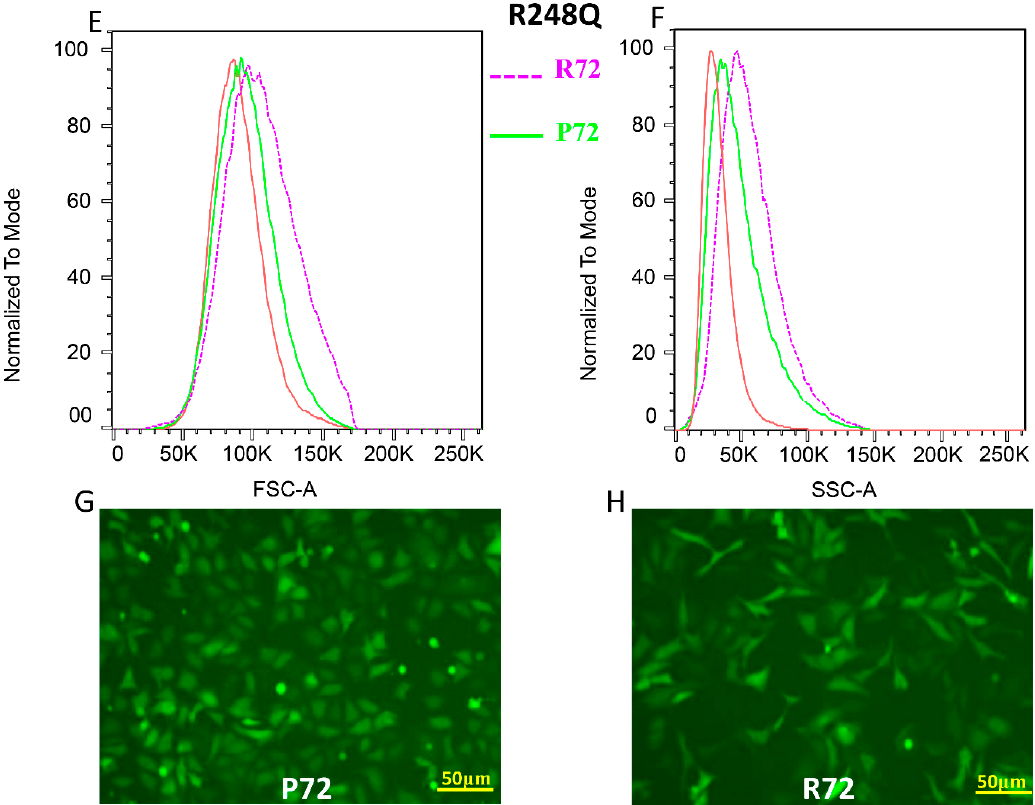
Figure 1. The P72R SNP alters the morphology of p53 mutants ( A , B ) Flow cytometry analysis showing the Forward Scatter (FSC) and Side Scatter (SSC) of p53 mutant R248W with the P72 SNP (green) and p53 mutant R248W with the R72 (purple). SKOV3 parental cells (Red) were used as unstained control for gating. ( C , D ) Fluorescent microscopy images showing the morphological changes observed in p53 mutant R248W with the P72 SNP (left) and p53 mutant R248W with the R72 (right). ( E , F ) Flow cytometry analysis showing the Forward Scatter (FSC) and Side Scatter (SSC) of p53 mutant R248Q with the P72 SNP (green) and p53 mutant R248Q with the R72 (purple). SKOV3 parental cells (Red) were used as unstained control for gating. ( G , H ) Fluorescent microscopy images showing the morphological changes observed in p53 mutant R248Q with the P72 SNP (left) and p53 mutant R248W with the R72 (right). In 1C, D, G and H, transduced pools were used. FSC Chi-Squared T(X) for R248W + R72 compared to R248W + P72 = 689 and SSC Chi-Squared T(X) = 526. FSC Chi-Squared T(X) for R248Q + R72 compared to R248Q + R72 = 485 and SSC Chi-Squared T(X) = 252.